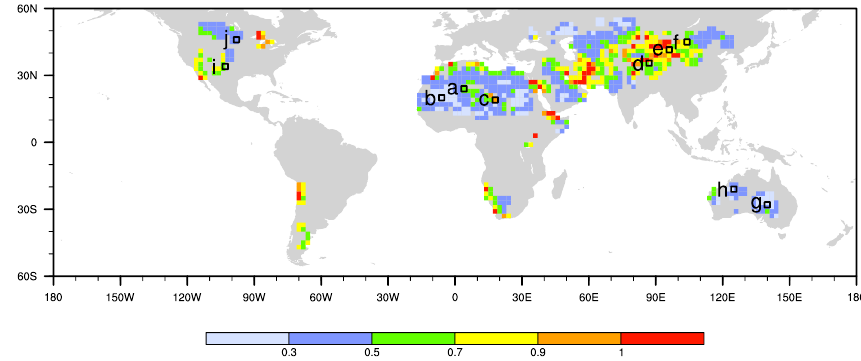
Figure 10. Geographical distribution of the coefficient D (unitless) derived for a 2 ◦ lat × 2 ◦ long GCM grid using the ECMWF 15km analysis of the year 2011 and Eq. (26). The locations with no results are either covered by land ice or lake, or associated with leaf area indices (LAI) larger than 0.3 throughout the year; thus, cannot have dust emission according to the parameterization of Zender et al. (2003) and the land surface characteristics data used in the CAM5 simulations in this paper. The black boxes correspond to the panels in Fig. 11 in which time series of sub-grid wind variability are